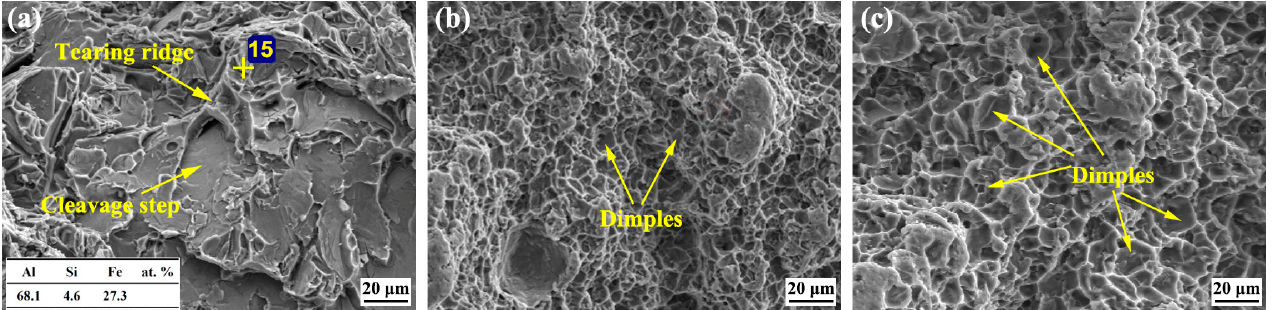
Figure 8. Tensile fracture morphology of Al alloy/steel joints under different thicknesses of Ni coating: ( a ) without Ni coating; ( b ) with 5 μ m Ni coating; ( c ) with 10 μ m Ni coating.